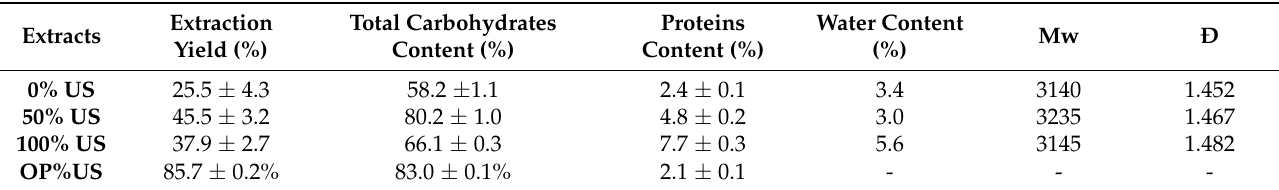
Table 1. Composition, Molar mass (Mw), and dispersity (Ð) of the